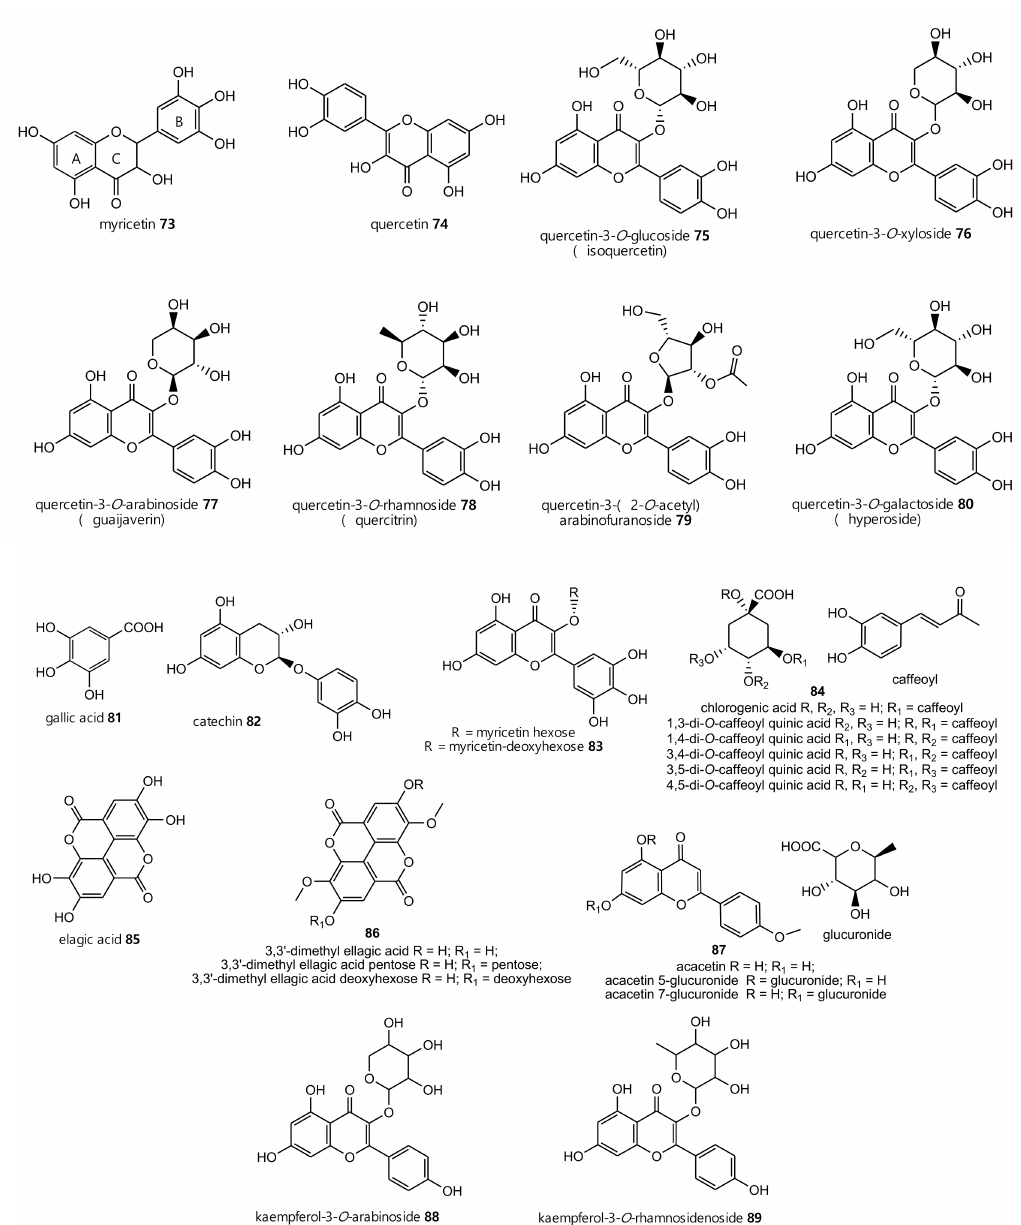
Figure 3. Phenolic compounds identified from E. characias latex (compounds 73 , 74 ) [30] and aerial parts (compounds 74 – 89 )